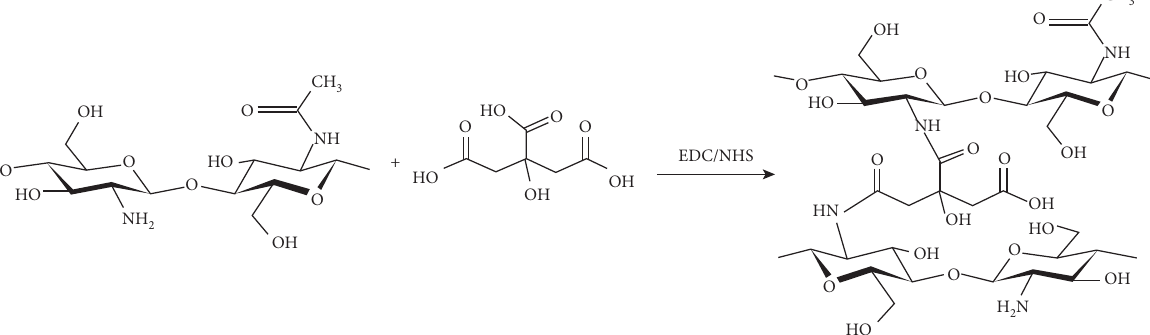
Figure 4: Synthesis of CS-citrate nanogel (structure in the right) from CS and citrate using EDC and NHS as the activation